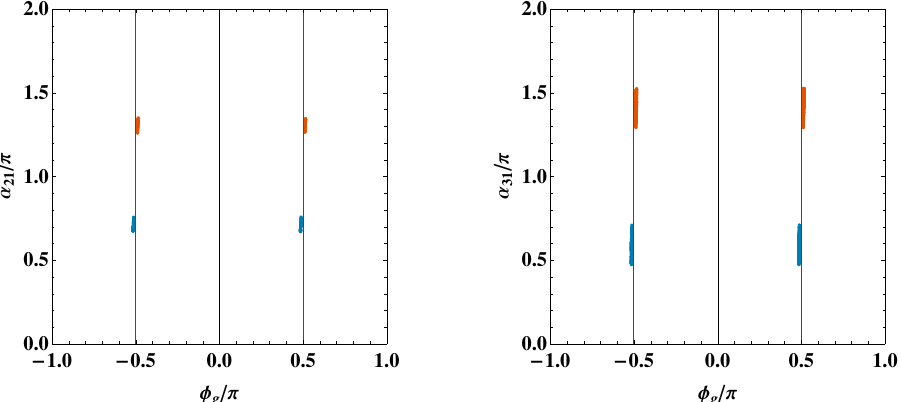
Figure 2 . The allowed regions of (cid:11) 21 and (cid:30) g (left) and that of (cid:11) 31 and (cid:30) g (right). At the orange (blue) points the sign of Y B is positive